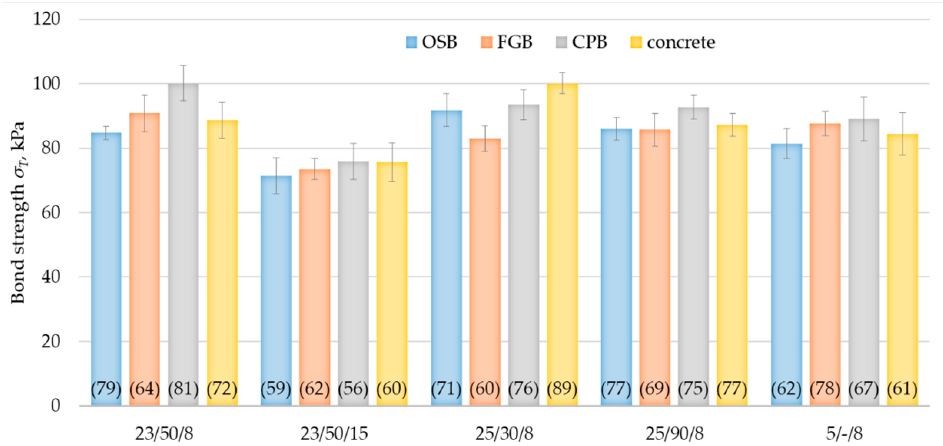
Figure 7. Bond strength results for PU adhesive bonds made under different thermal and moisture conditions. Error bars show standard deviation values. The minimum value for the series is given in brackets.